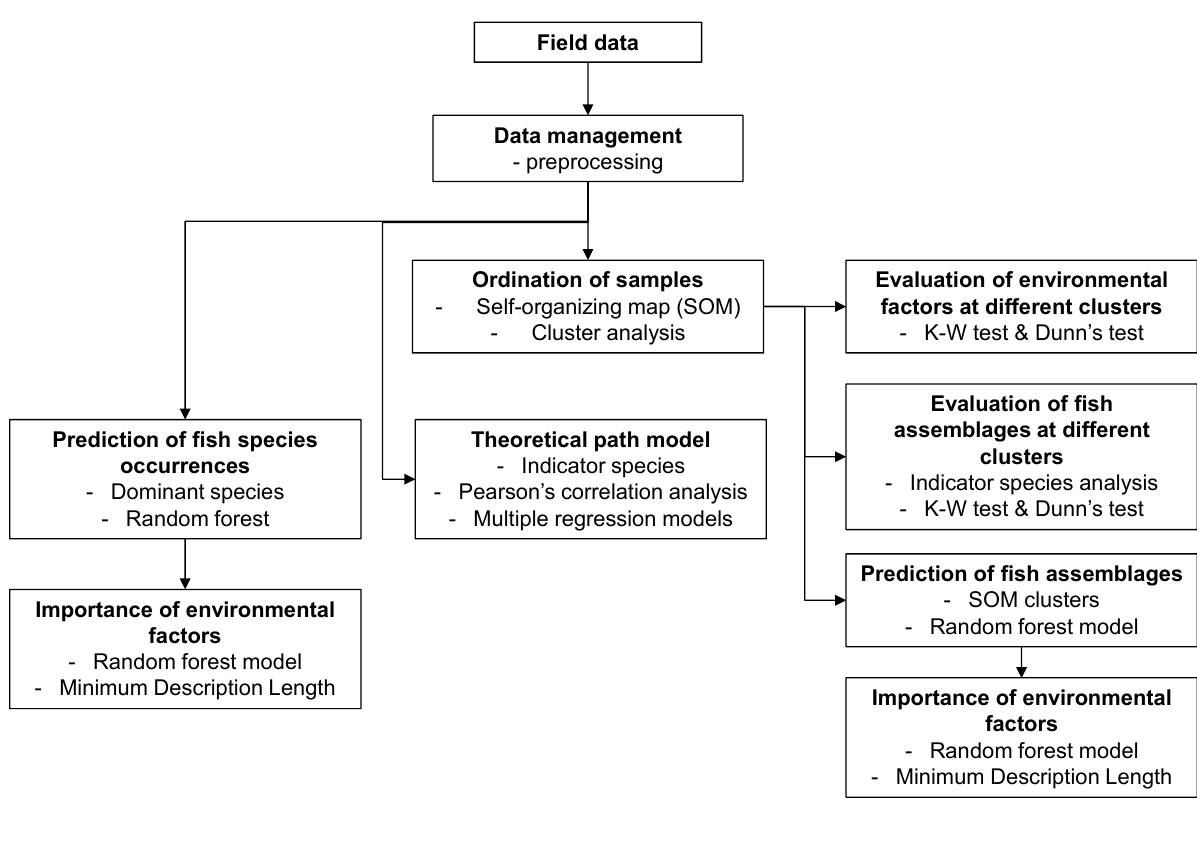
Figure 2. Overall data analyses